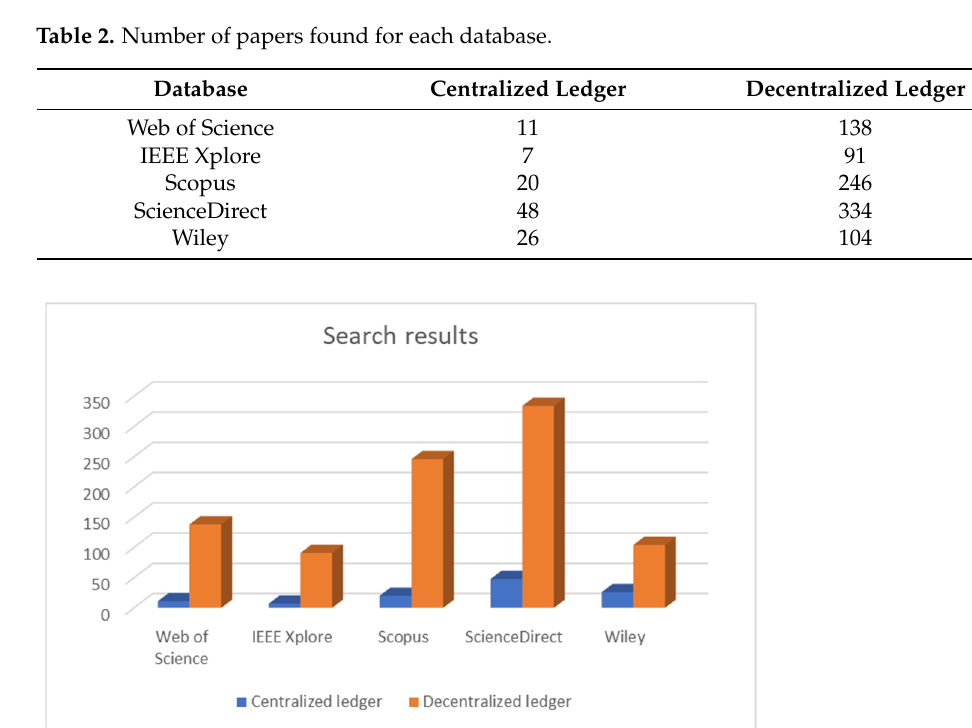
Figure 1. Number of articles found in each of the selected scientific databases.